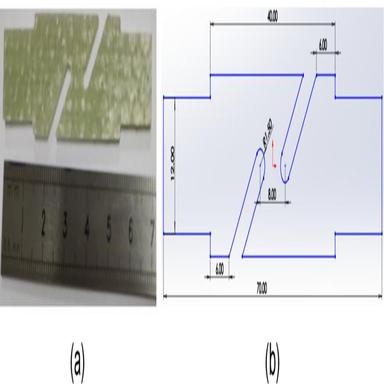
Plain woven glass-fiber reinforced shear specimen: (a) Shear specimen; (b) The size of specimen.